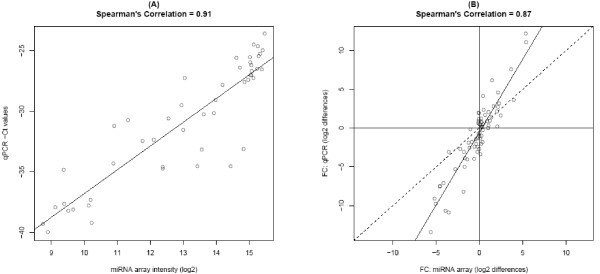
Correlation of array and qPCR results. (A) A scatterplot illustrating the association of raw miRNA array expression (log2) versus the negative CT value (Spearman's correlation 0.91) is used to assess the quantification capabilities of the array in a single sample. (B) All pairwise differences (log2) between the four cell lines were computed both within the array and qPCR data and plotted to assess the quantification capabilities of the array for relative differences between samples (Spearman's correlation 0.87). Included in the scatterplot are both the dotted y = x line as well as the solid regression fit line (y = -0.56 + 1.88x).